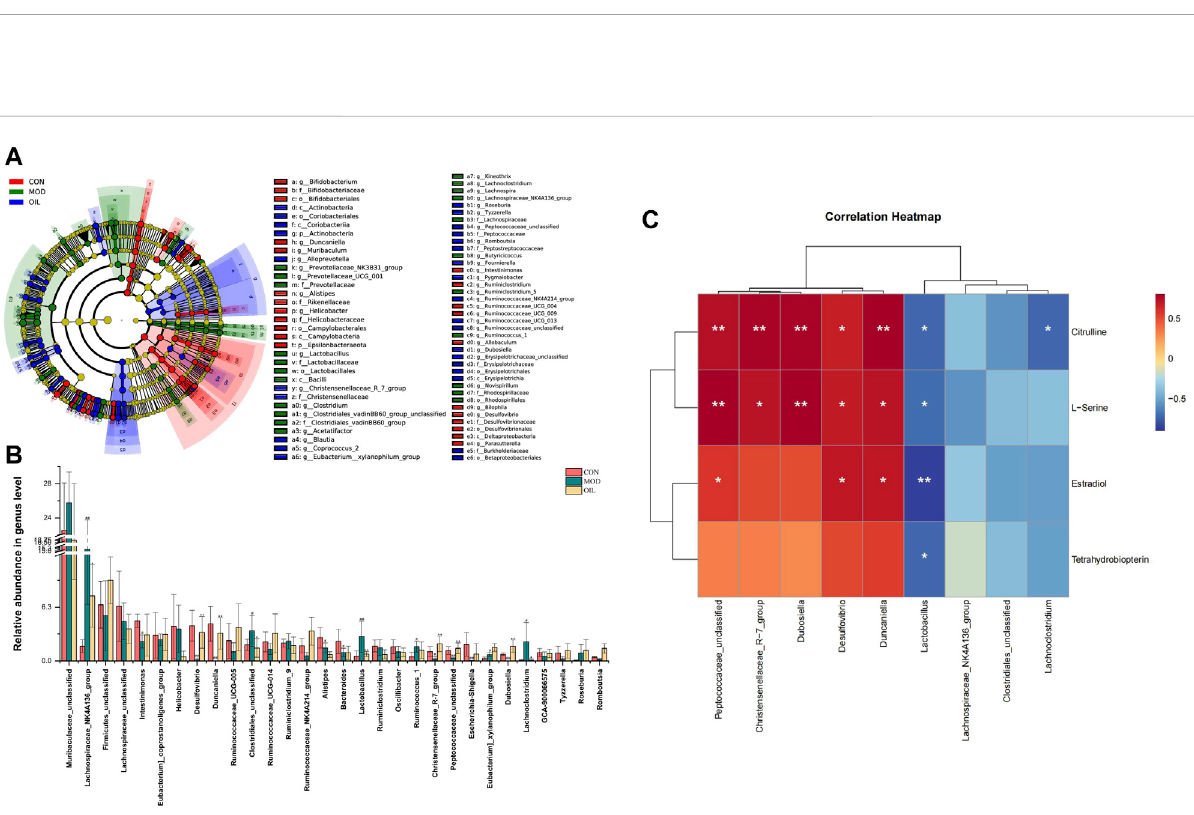
FIGURE 7 Species composition abundance map atthegenuslevel (A) . Abundanceclustering heat map ofthe genera (B) . The closer to blue, thelower the abundance, and the closer to red, the higher the abundance. Buble plot at the genus level (C) . The color represents the phylum respectively.